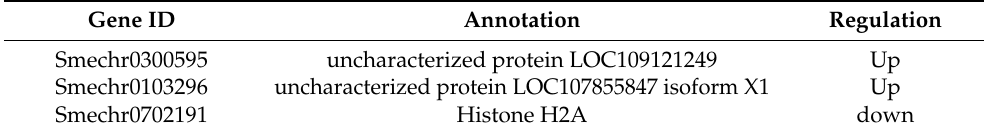
Table 3. The difference in peak-associated genes between R0 h and R48 h. Gene